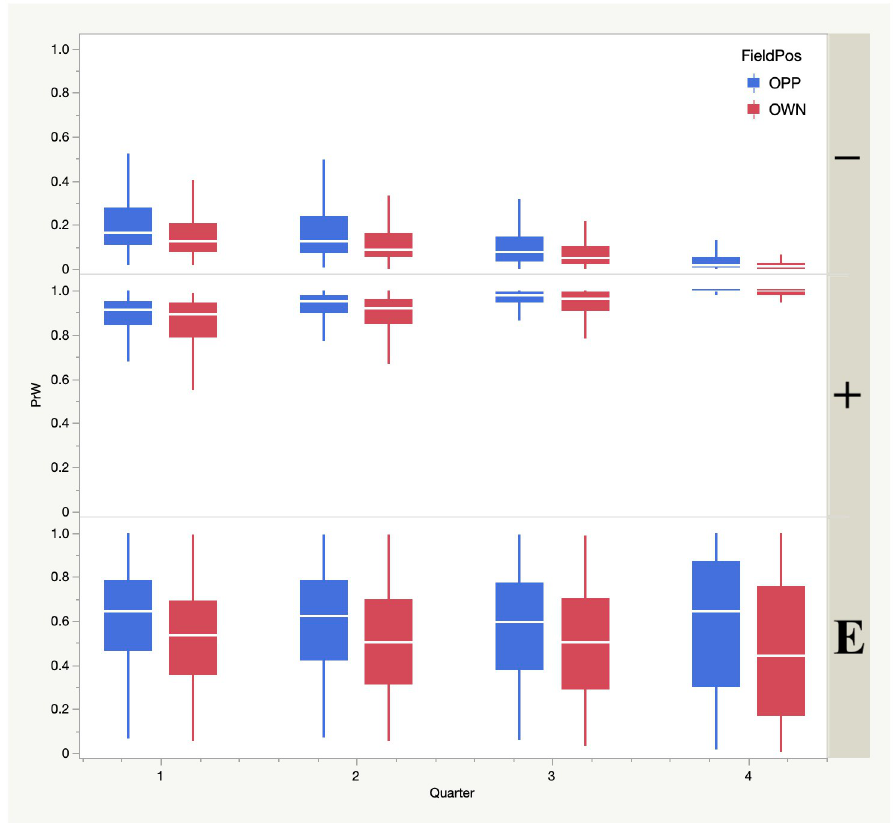
Fig 2. Box plots (10 th , 25 th , 50 th , and 75 th , and 90 th percentile) showing the artificial neural network (ANN) prediction of the probability of a win ( PrW ) as a function of game state. Shown are field position, indicating whether a team has possession on their side of the field (OWN, red) or the opponent’s side (OPP, blue), the quarter, and whether leading (+), trailing (–), or within 1 touchdown